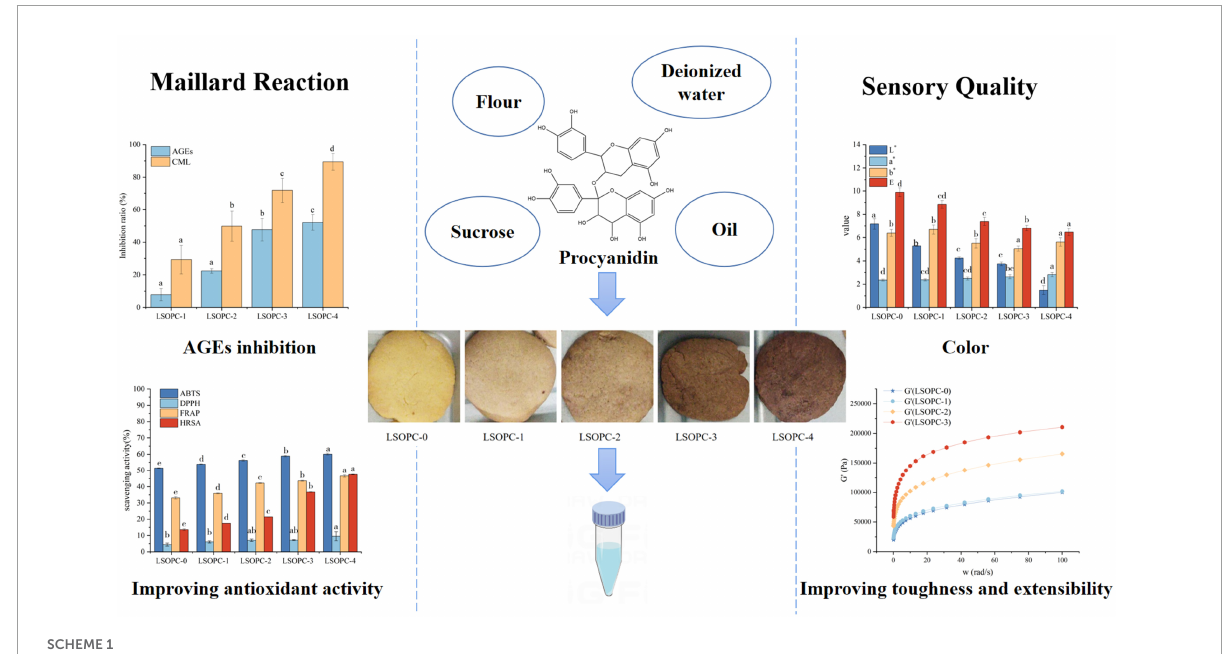
SCHEME1 Effect of LSOPC on